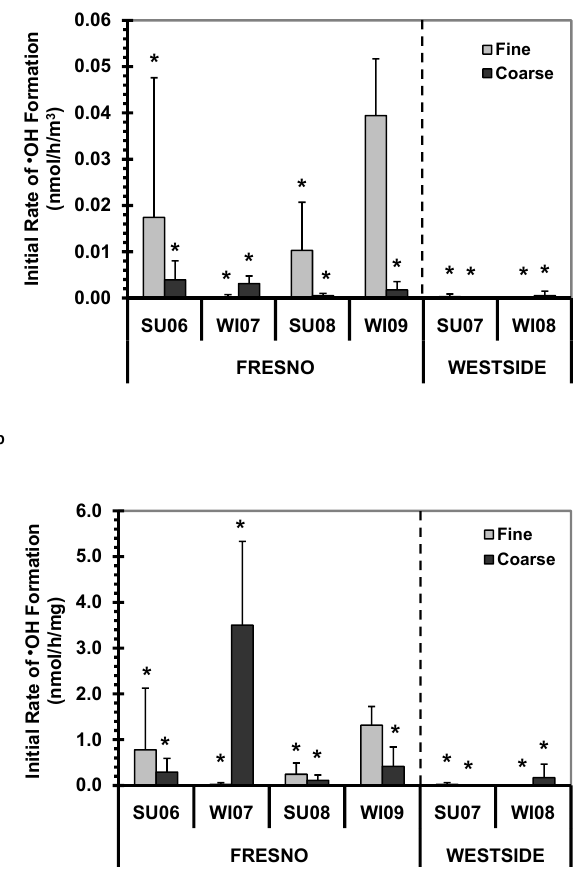
Fig. 5. Rates of • OH generation in the absence of ascorbate. Panel (a) shows air-volume-normalized initial rates of • OH forma- tion, while (b) shows PM-mass-normalized initial rates. Values are means ± SD, n = 3. An asterisk “*” indicates a value that is not statistically different from zero.